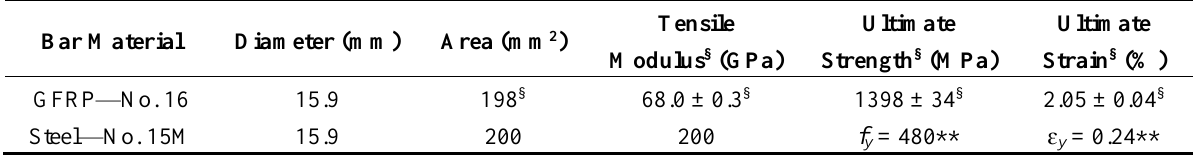
Table 2. Properties of reinforcing